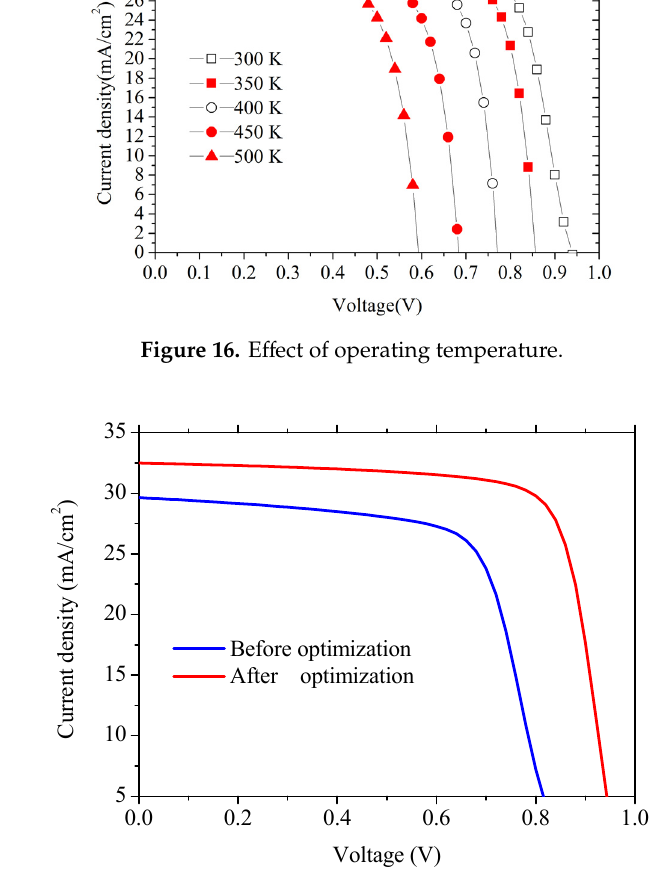
Figure 17. J-V characteristics before and after optimization.